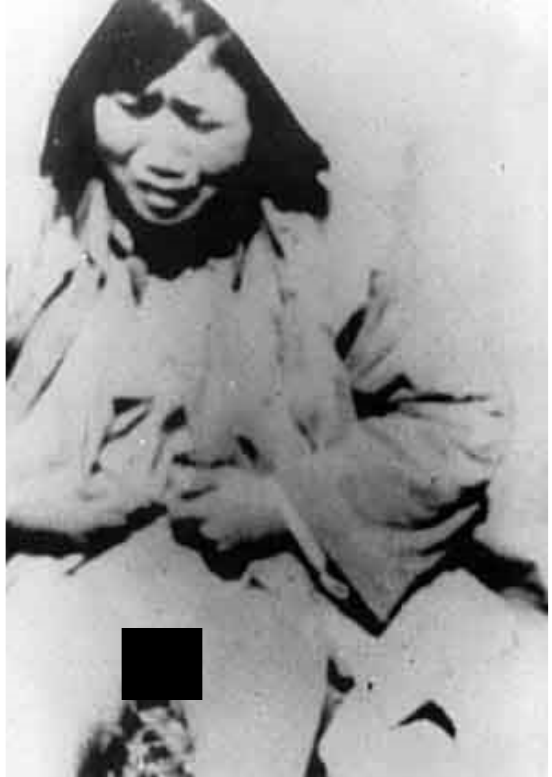
Figure 15. The humiliation of sexually ravaged women. Source: Nanjing Massacre Memorial